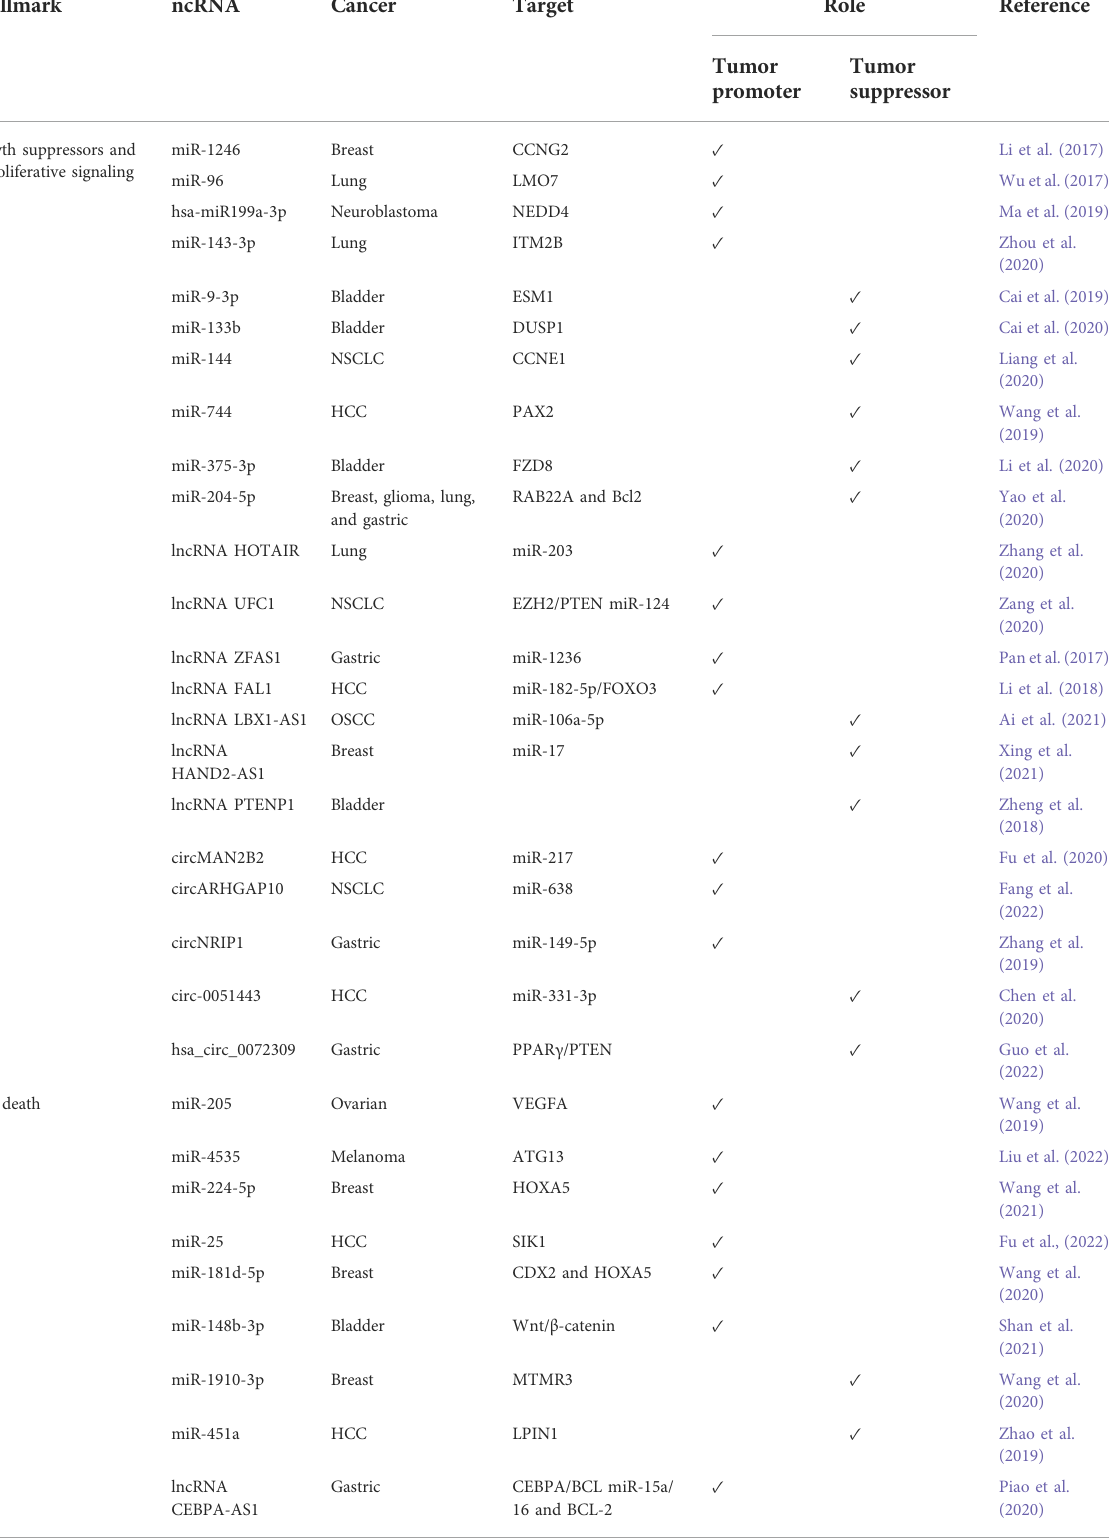
TABLE 1 Tumor-promoting and tumor-suppressing roles of exosomal ncRNAs in hallmarks of cancer. Cancer